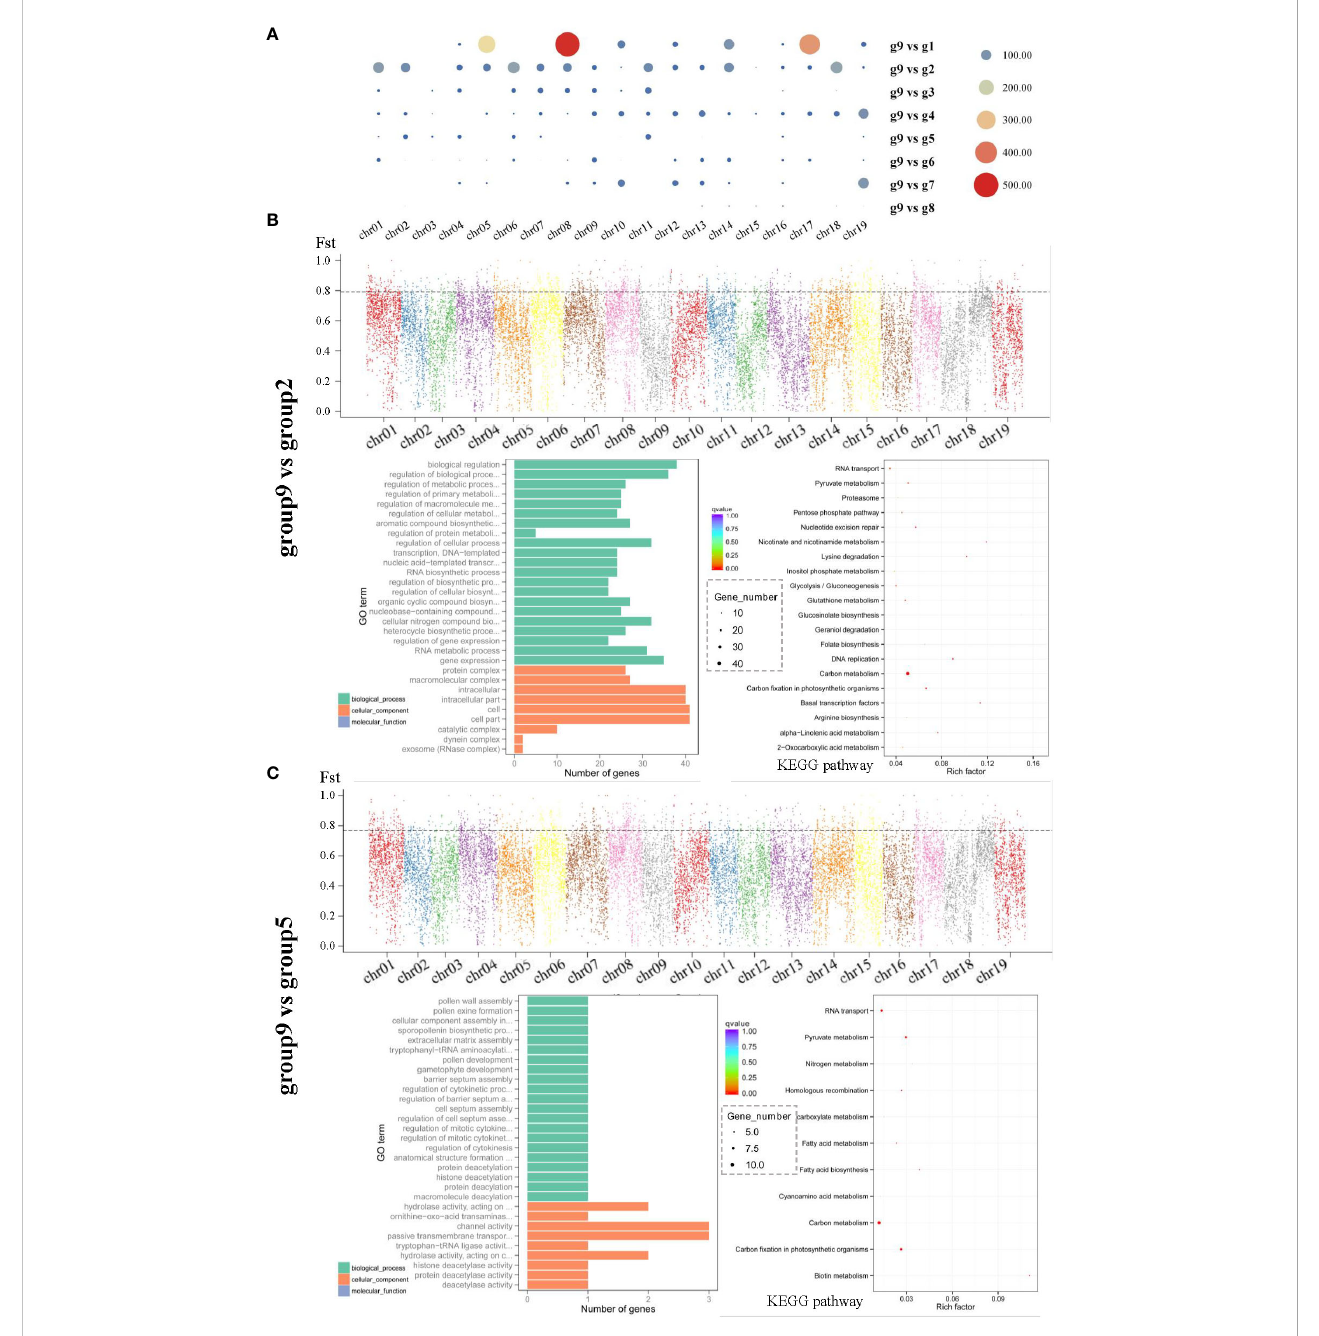
FIGURE 6 Selection elimination and gene enrichment analysis of the Chinese population and other groups. (A) Overlap Number (the x-axis represents different chromosomes, and the y-axis represents the number of corresponding overlaps). (B, C) group9 vs group2, group9 vs group5, Fst distribution map of eight groups (the x-axis represents different chromosomes, the y-axis represents the Fst value in the corresponding chromosome window, and the dotted line represents the selection threshold top 5%); and GO term and KEGG pathway enrichment of the candidate selective sweep genes (the size of the bubble represents the number of genes in the corresponding GO category, the color of the bubble shows the corresponding P- value, and the rich factor shows the percentage of enriched genes out of the total number in the GO